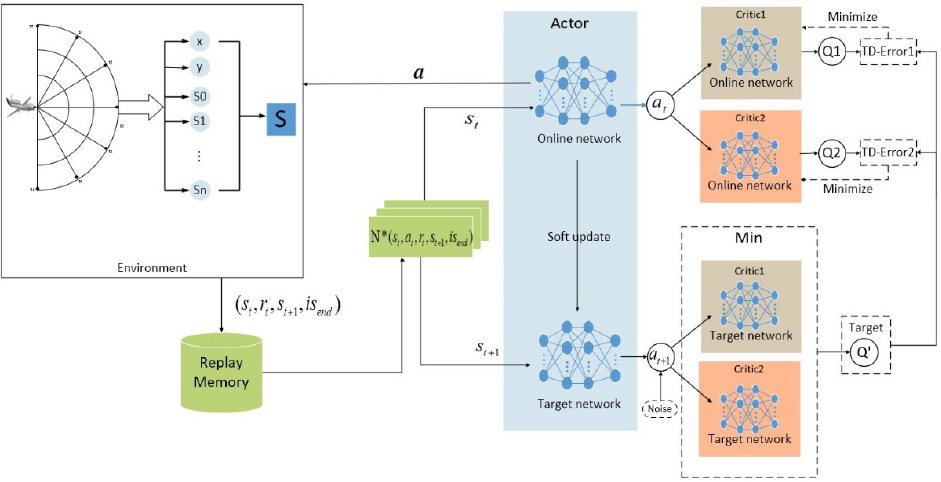
Figure 4. The combination of the state probing method and the TD3